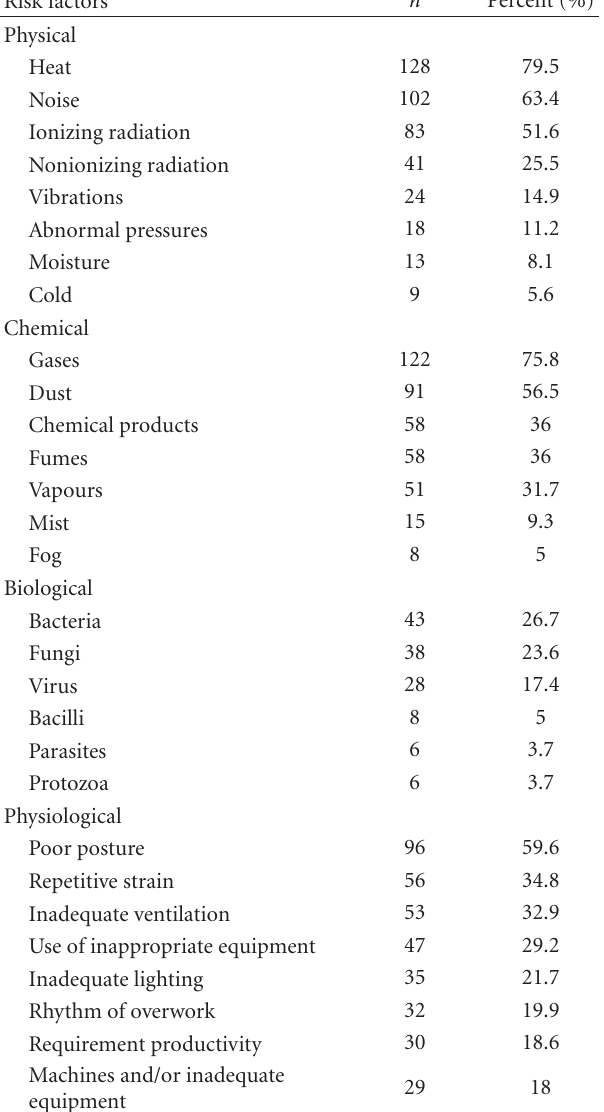
Table 2: Perception of apprentice welders about physical, chemical, biological, and physiological risk factors ( n = 161).